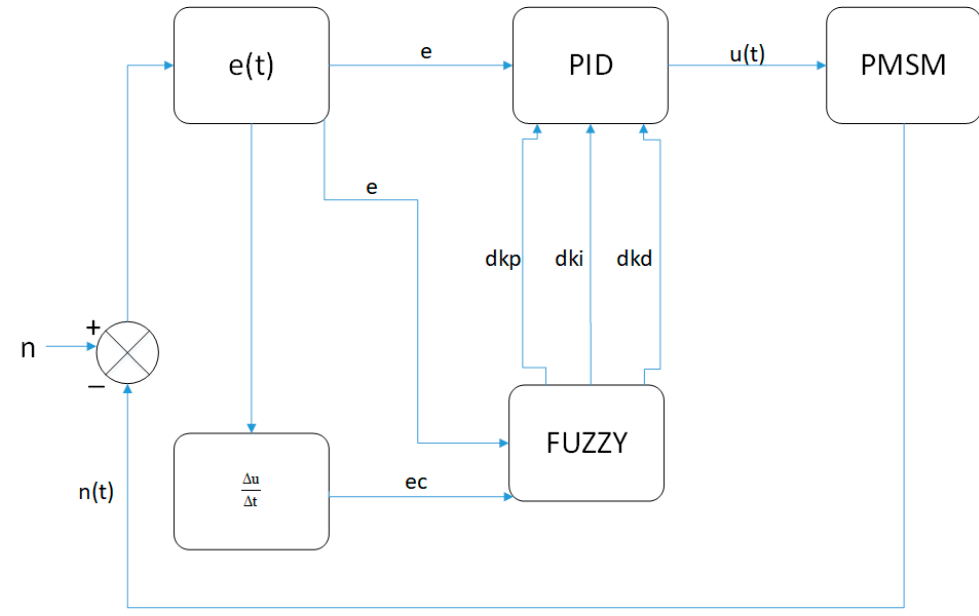
Figure 13. Fuzzy PID structure diagram.